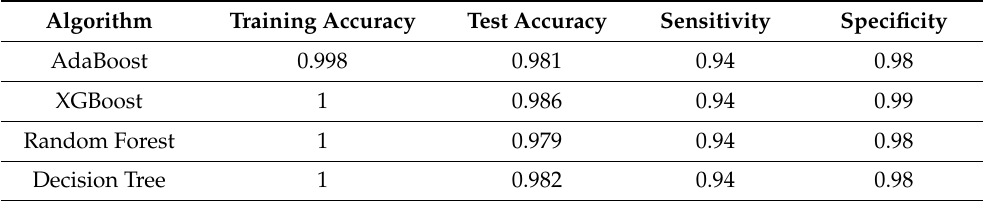
Table 5. Training accuracy, testing accuracy, sensitivity, and specificity of different models on VDengue dataset.